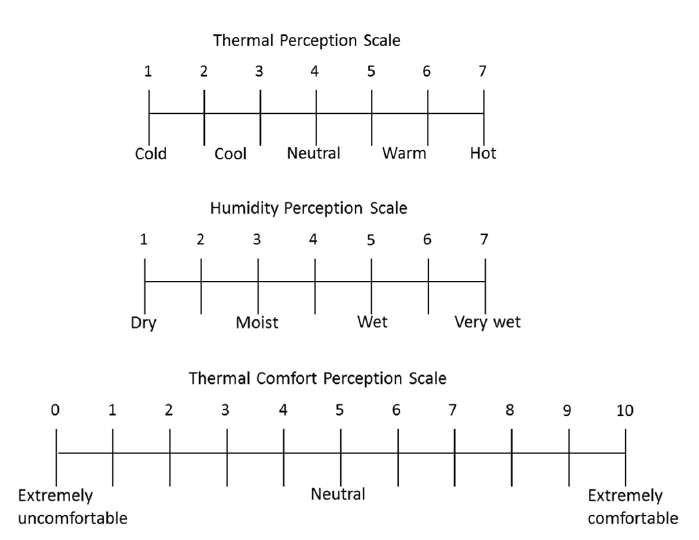
Figure 3. Rating scale of subjective sensations.